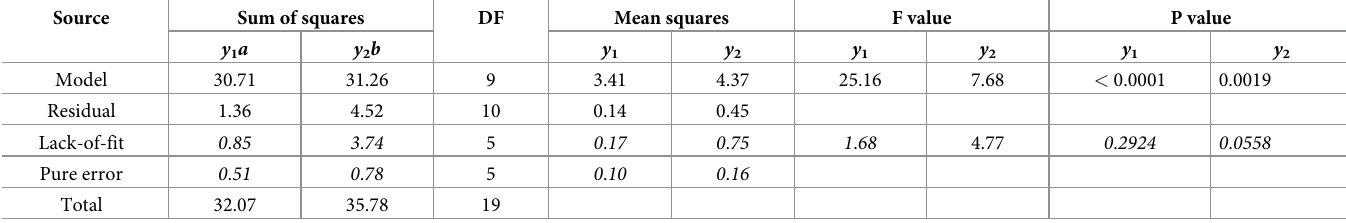
The presence of nutrient in the broth medium might protect the bacterial cells for the